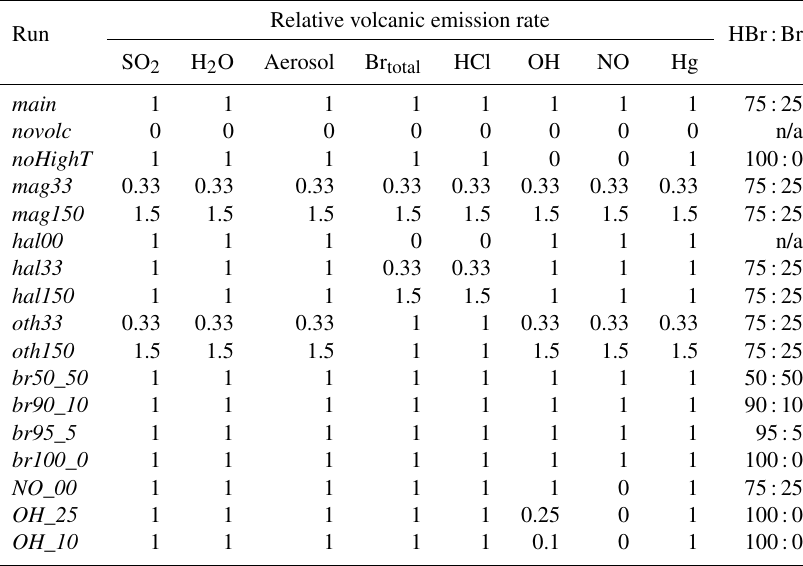
Table 2. Volcanic emission rates of species in the model runs of this study relative to those of main and speciation of bromine at emission; n/a stands for not